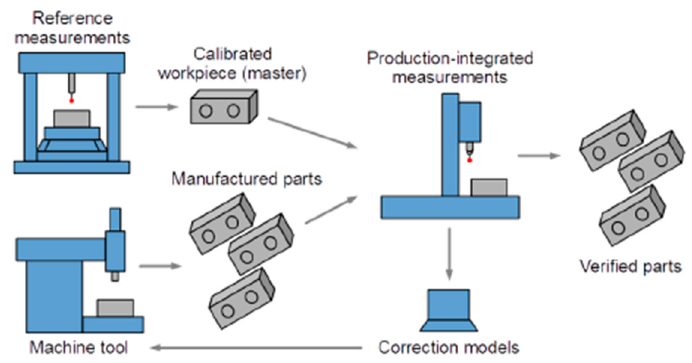
Figure 1. A practical approach to the ISO 15530 ‐ 3 [5].